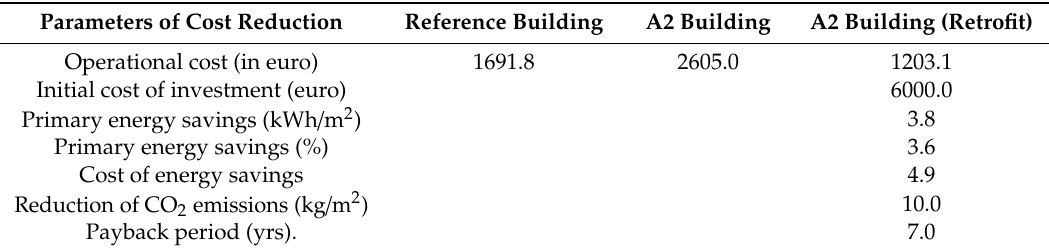
Table 5. Economics profile and payback period for the scenario applied to A2